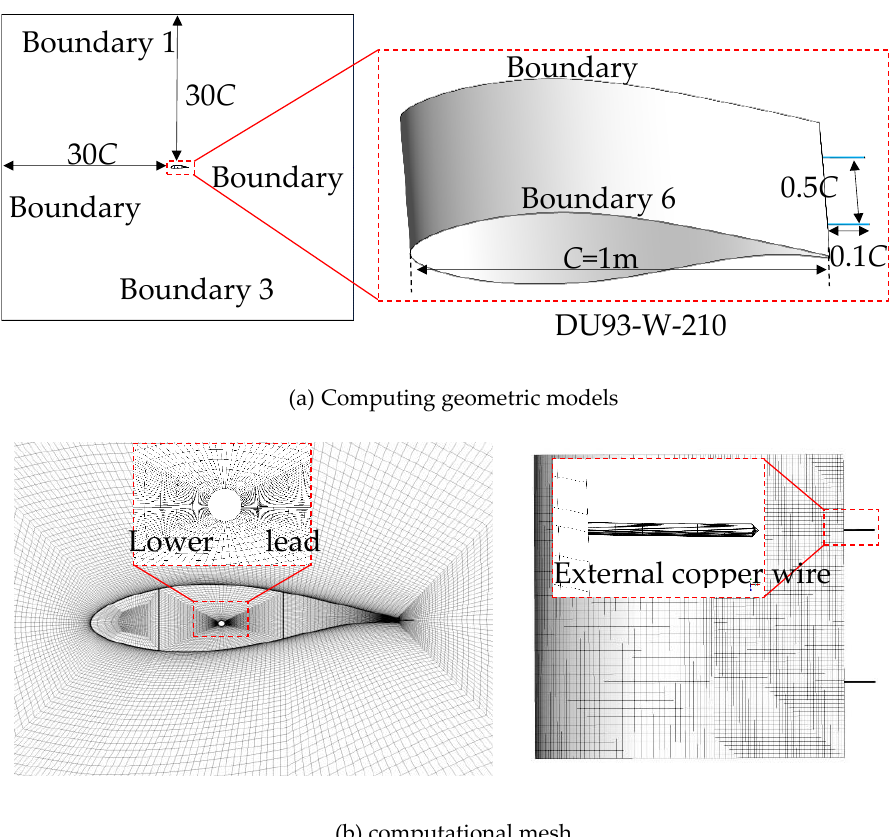
Figure 5. Computing geometric models (a) and computational mesh (b).